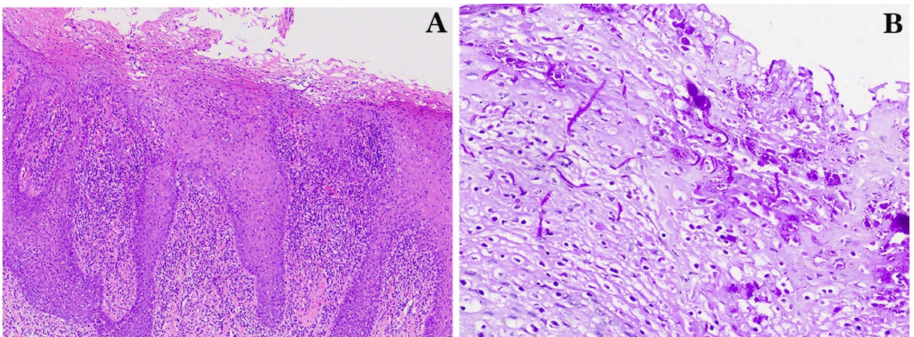
Figure 2. Patient 1. ( A ) Histopathologic examination revealing hyperparakeratosis, neutrophilic mi- croabscesses in the upper layers, thickened spinous layer with elongated rete pegs, and inflammation of the underlying connective tissue with exocytosis (H&E, initial magnification 100 × ). ( B ) Tubu- lar hyphae of Candida albicans are seen embedded in the parakeratin layer (PAS staining, initial magnification 200 ×